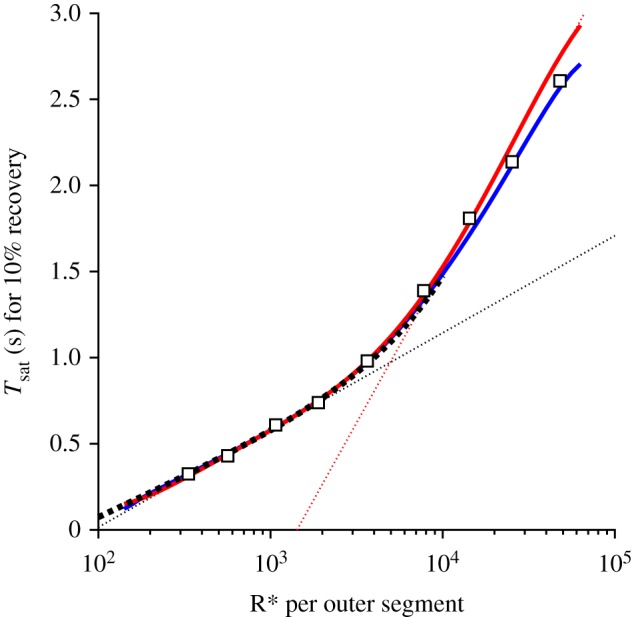
Saturation time Tsat versus flash intensity Φ, semi-logarithmically. Symbols are experimental measurements for mouse rods from fig. 4B of Burns & Pugh [22]. The blue and red curves are for method 2 (without aberrants) and method 3 (with aberrants), respectively, with parameter values as listed in tables 1 and 2. For both methods, the flash intensities ranged from 100 to 62 500 R*. For method 2 the intensities were spaced at intervals of 0.05 log10 units. For method 3 they were spaced at 0.1 log10 units and the smooth red curve is a fifth-order polynomial fitted through the measurements. For the aberrant R* events, the probability of occurrence was paberr = 0.002, the mean stochastic lifetime was τaberr = 4 s and the activity relative to full R* activity was aaberr = 0.25. The heavy dotted black curve plots equation (5.18) with ρ = 0.32 and vertical shift 585 ms. The dotted straight lines have slopes corresponding to dominant time constants of τD1 = 245 ms and τD2 = 780 ms, and intersect at a transition intensity of Φtrans ≈ 4900 R* per rod.